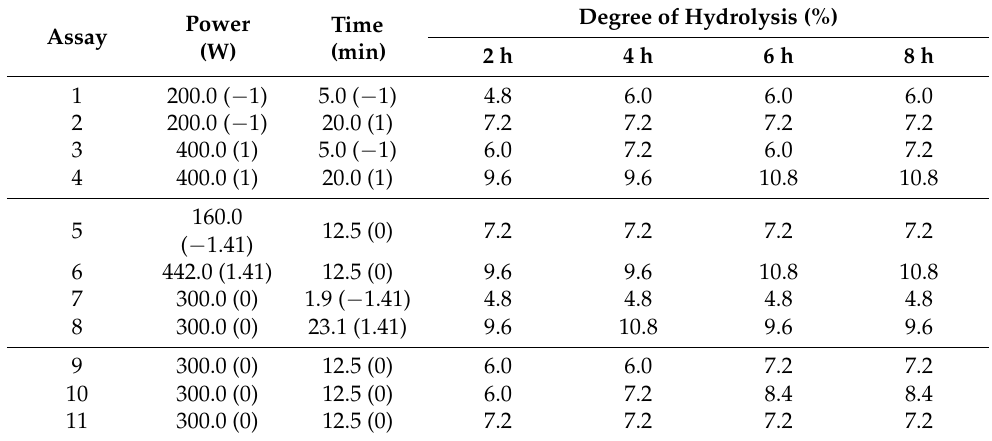
Table 5. Design of experiments 2 2 sequential hydrolysis composed of ultrasound and enzymatic steps. Assay